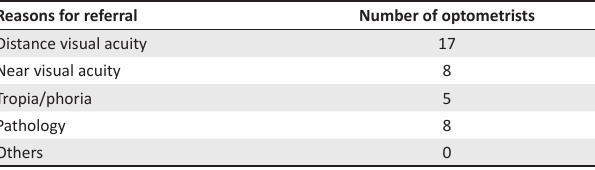
TABLE 5: Reasons for referral of children seen in optometric clinics from vision screening programmes. Reasons for